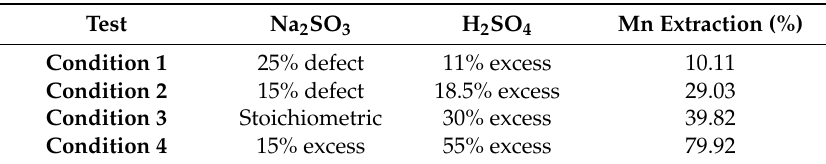
Table 3. Low temperature process after 30 s milling.